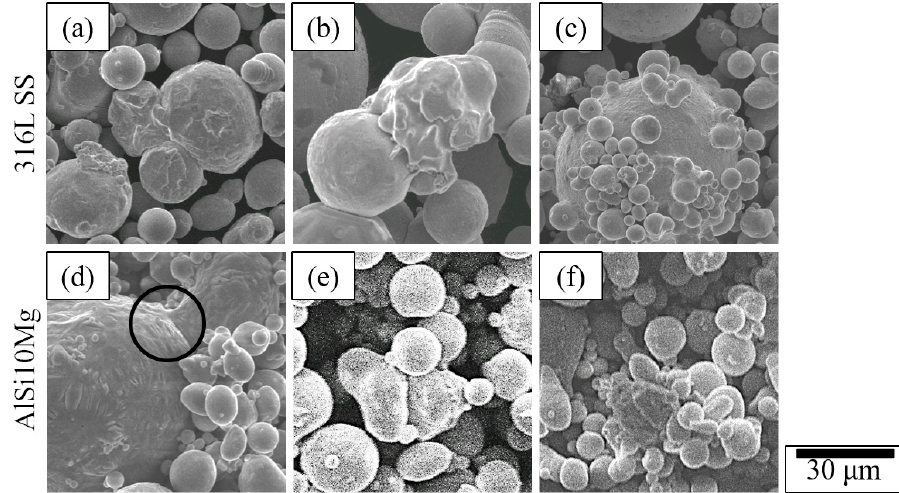
Figure 2. Examples of powder morphologies for recycled 316L SS ( a – c ) and AlSi10Mg ( d – f ): ( a , d ) Deformed powders, rough surface, and sintering necks (circled area in Figure 2d); ( b , e ) incomplete powder melting and fusion; and ( c , f ) powder agglomeration due to spatter.